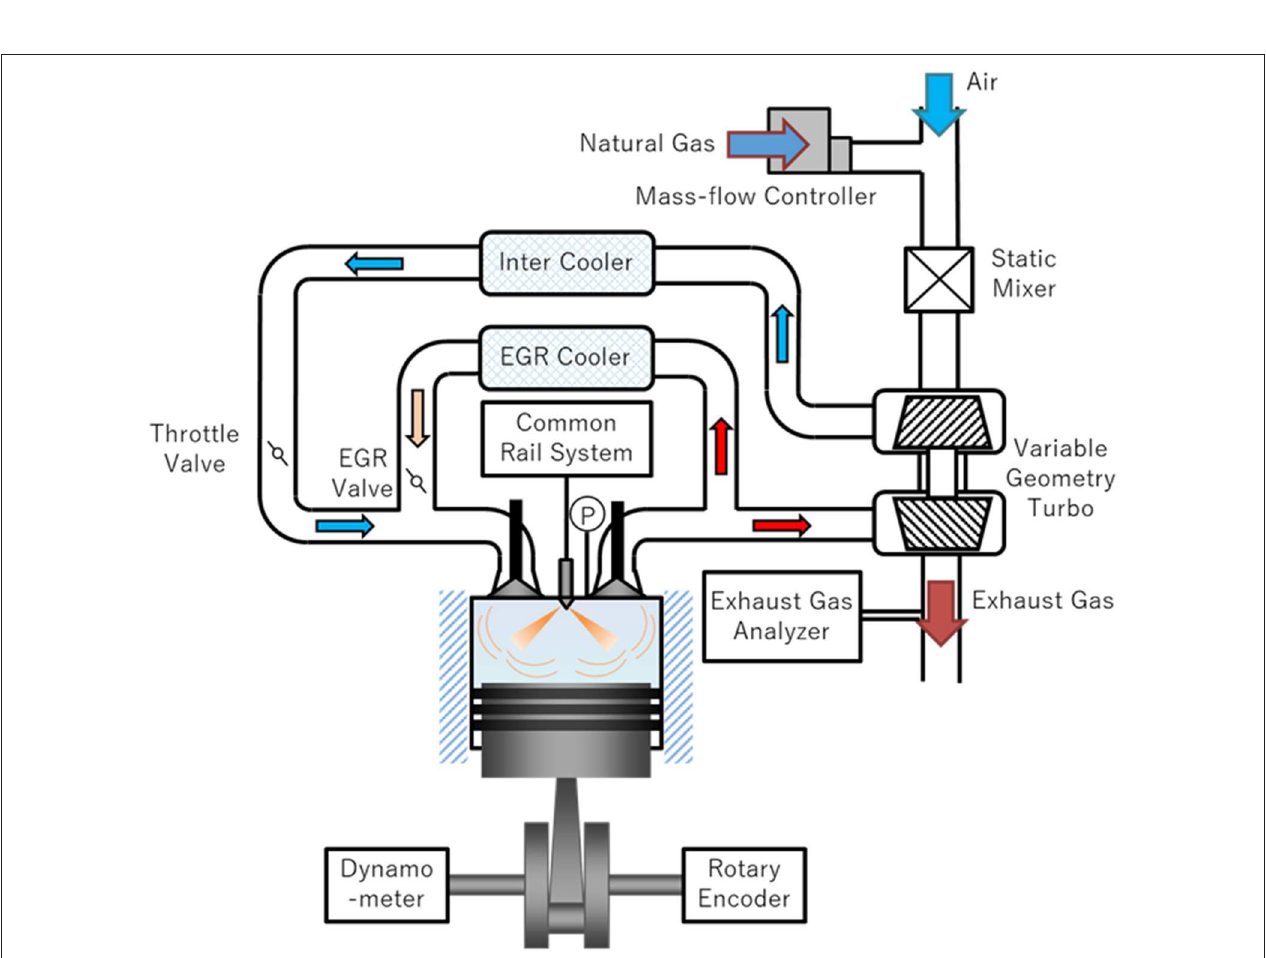
FIGURE 5 | Experiment setup for DFE combustion control model